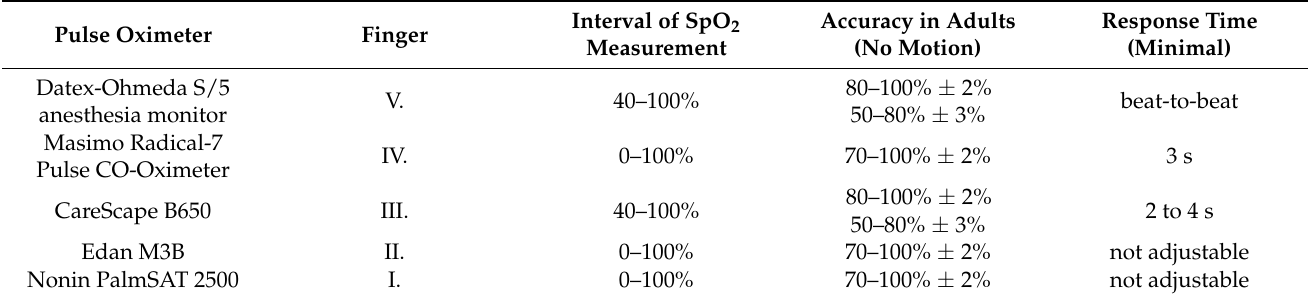
Table 1. A list of used pulse oximetry devices, their standardized placement on subjects’ right-hand fingers, the manufacturer guaranteed accuracy in the defined measurement intervals of peripheral saturation ( SpO 2 ) and the minimal response time set [21–25]. Interval of SpO 2